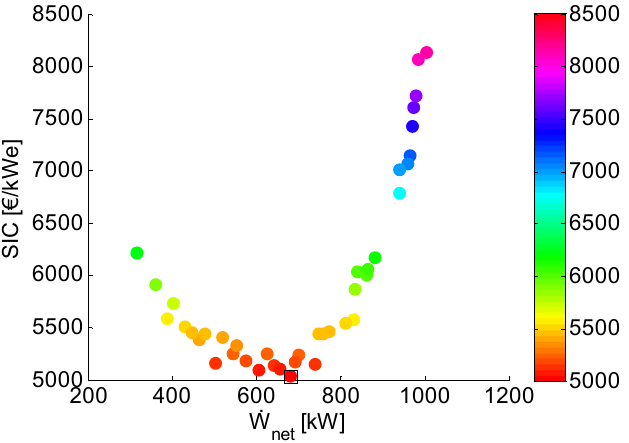
) for the transcritical organic Rankine (cid:3041)(cid:3032)(cid:3047)